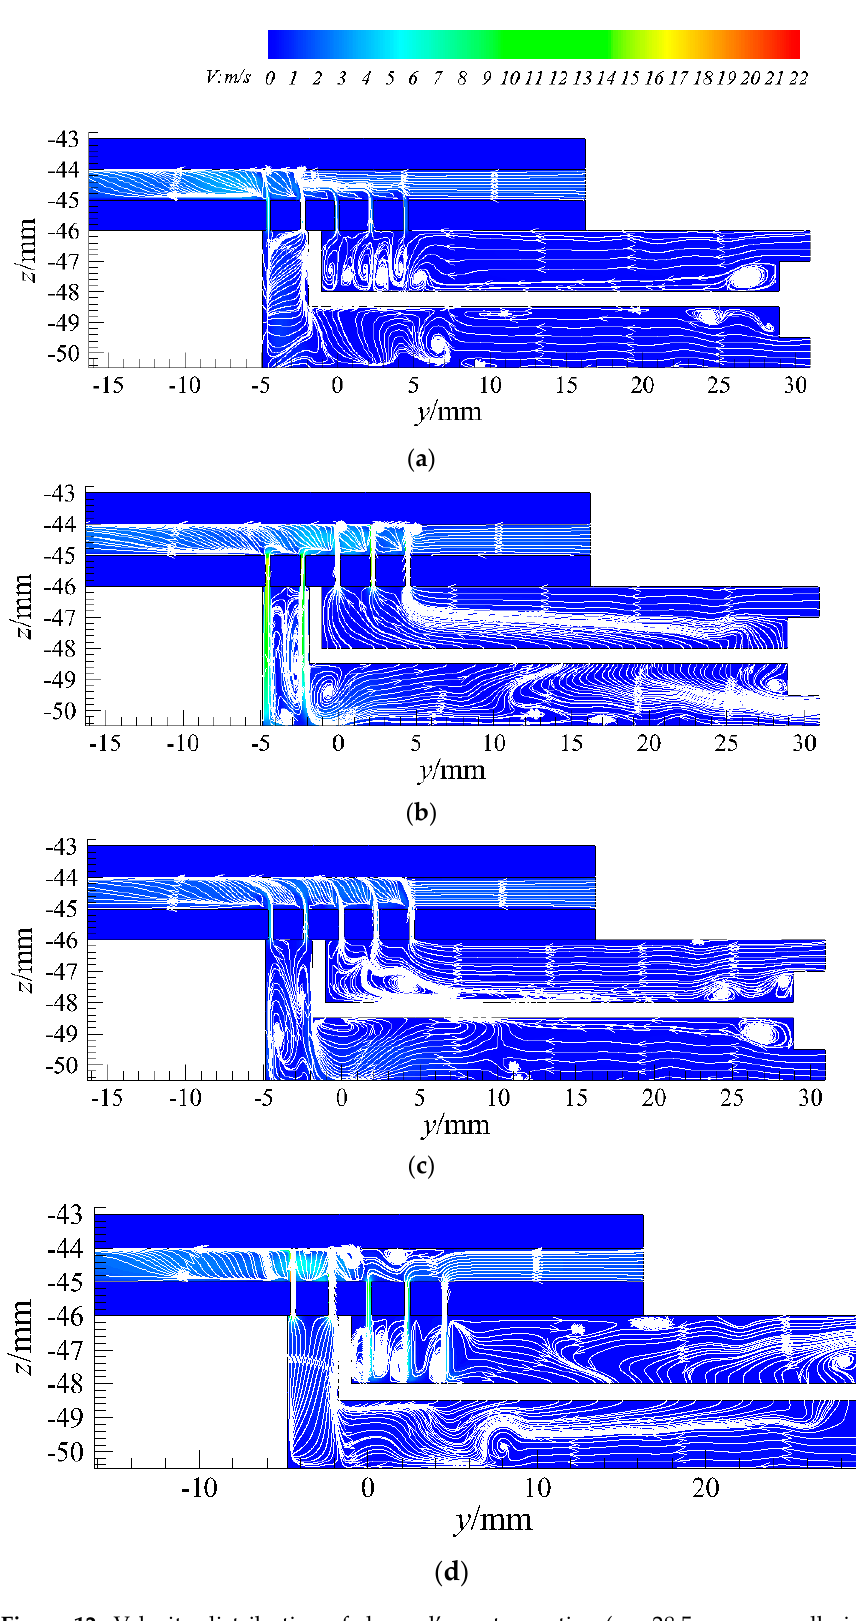
Figure 12. Velocity distribution of channel’s center section ( x = 28.5 mm, overall view) (DSJ on): ( a )